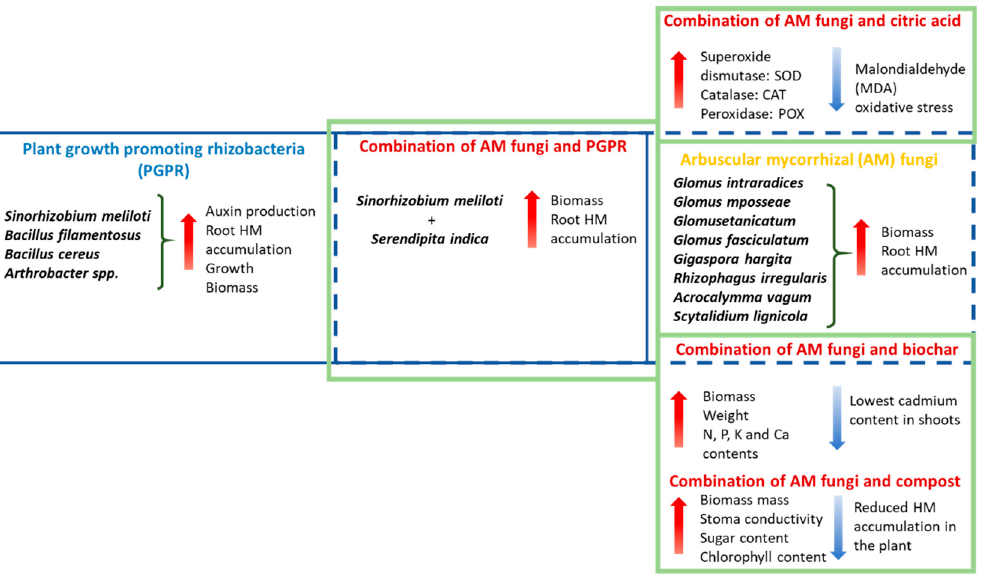
Figure 4. Single and combined application of AM fungi, bacteria, and organic substances, and their investigated effect on plant metabolism